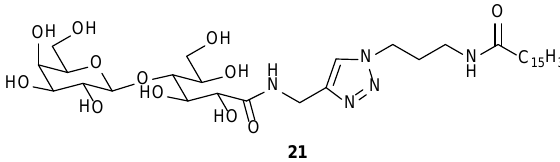
Figure 16. Triazole appended lactobionic acid amide based glycolipid.